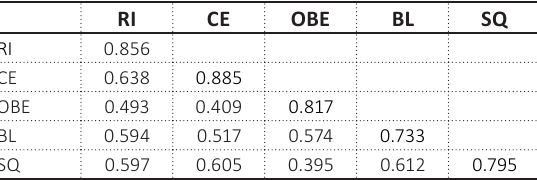
Table 3. Discriminant